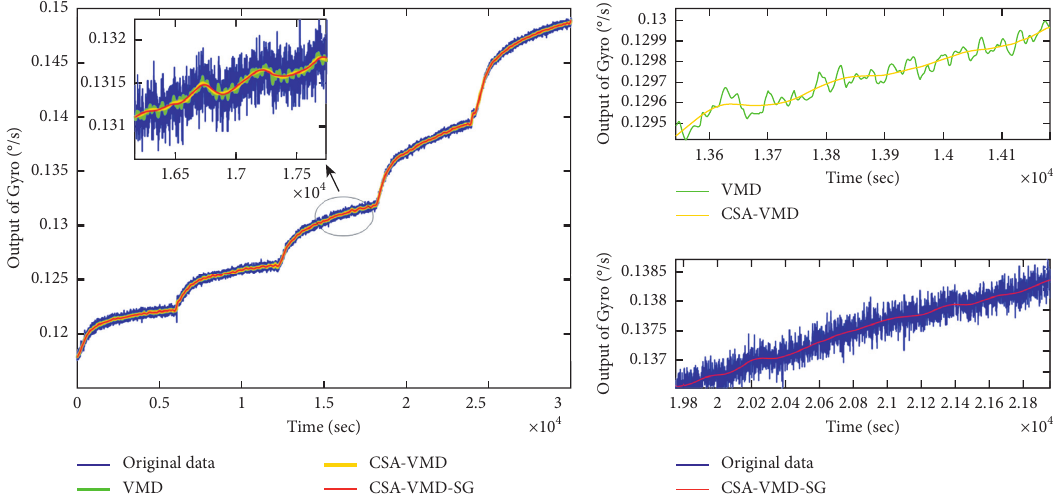
Figure 16: Denoised signal after CSA-SG-LSSVM.